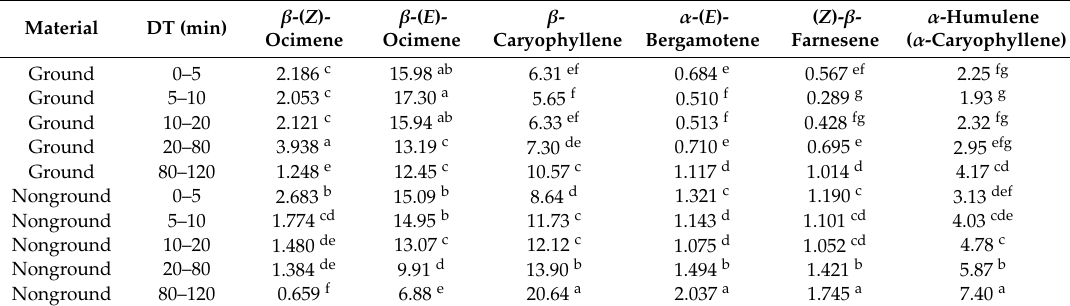
Table 3. Mean concentration (%) of β -( Z )-ocimene, β -( E )-ocimene, β -caryophyllene, α -( E )-bergamotene, ( Z )- β -farnesene, and α -humulene ( α -caryophyllene) obtained from the 10 combinations of Material and Distillation time